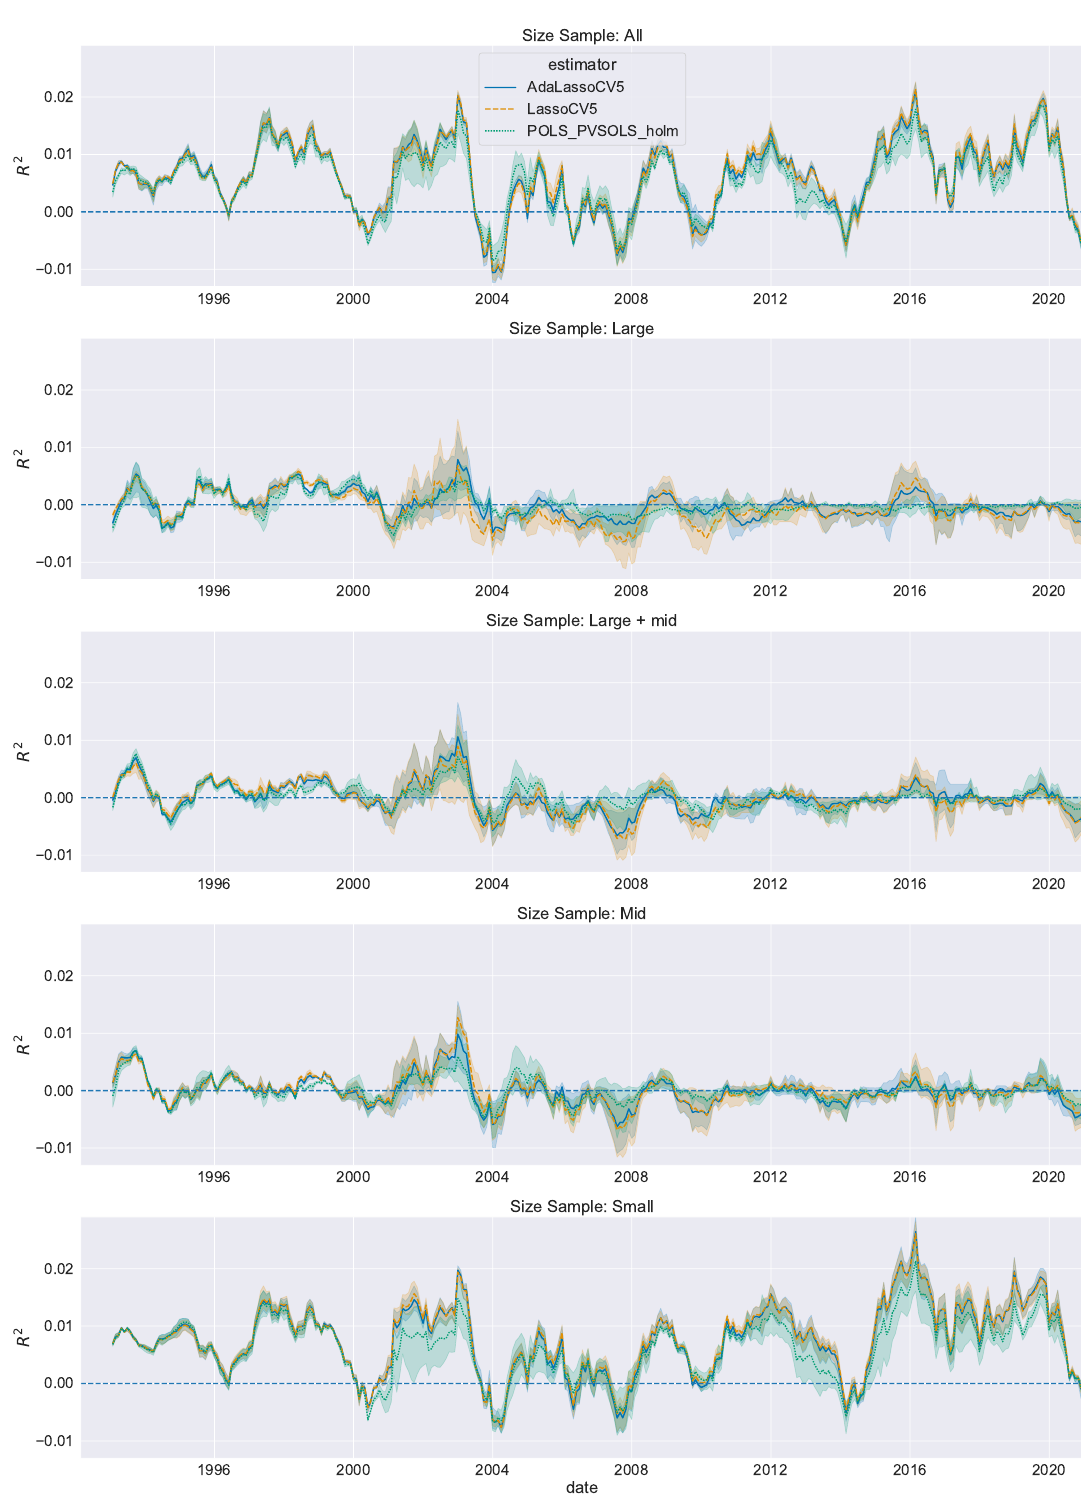
Figure 4. 12-month rolling R 2 (best seen in color): The figure shows the 12-month rolling R 2 as defined in (8) of each of the five different size groups. We aggregate the four different estimation window types per method and display the central tendency with confidence